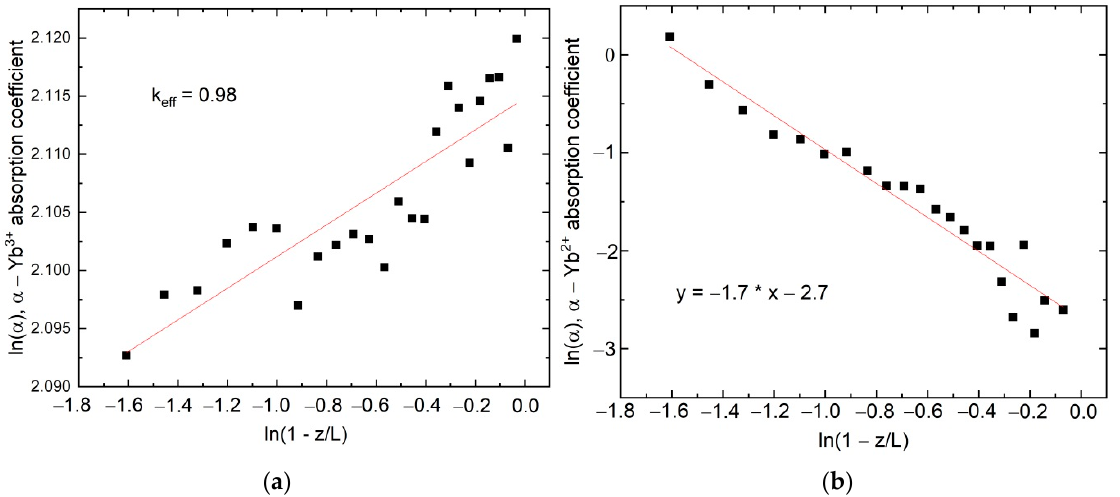
Figure 7. ( a ) Yb 3+ and ( b ) Yb 2+ absorption along the LiY 0.8 Yb 0.2 F 4 crystal in ln( α ) vs. ln(1 − z/L) coor- dinates, where α is the absorption coefficient, z represents the beginning of the sample crystallization, and L is the full length of the sample.